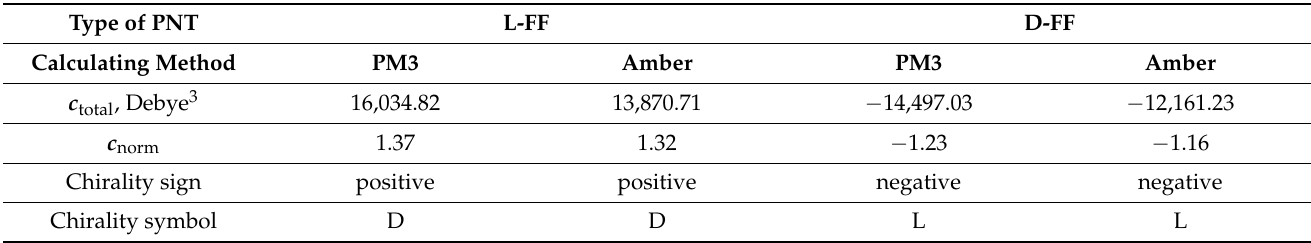
Table 5. Magnitudes and signs of the chirality obtained for L-FF and D-FF PNTs for various calculating methods. Type of PNT L-FF